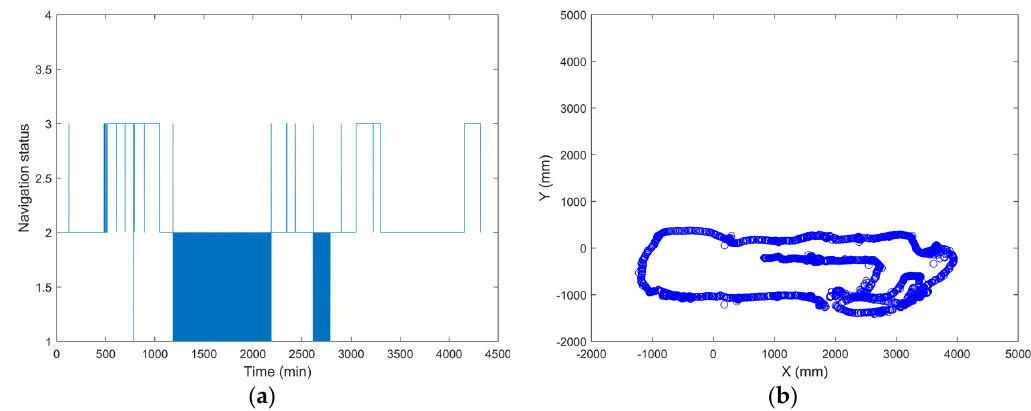
Figure 15. System stability experiment for long-term operation: ( a ) navigation status; ( b ) navigation trajectory curve with time elapse.